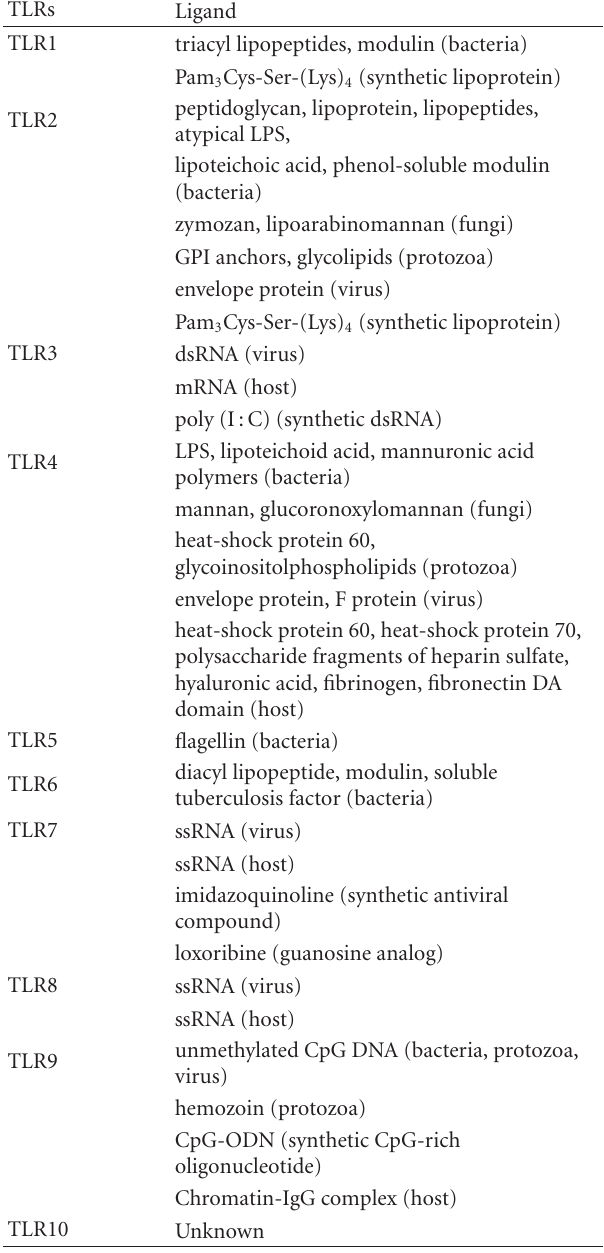
Table 1: Human TLRs and their cognate